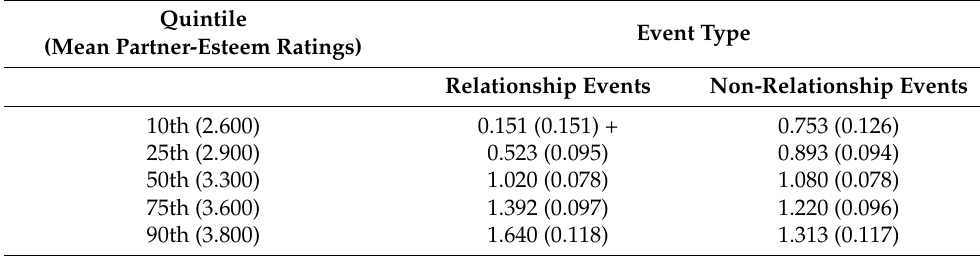
Table 2. Fading Affect Bias Regression Coefficients (SE) for Relationship Events and Non-Relationship Events across Quintiles (Mean Rating) of Partner-Esteem Ratings (large positive coefficients represent large FAB).